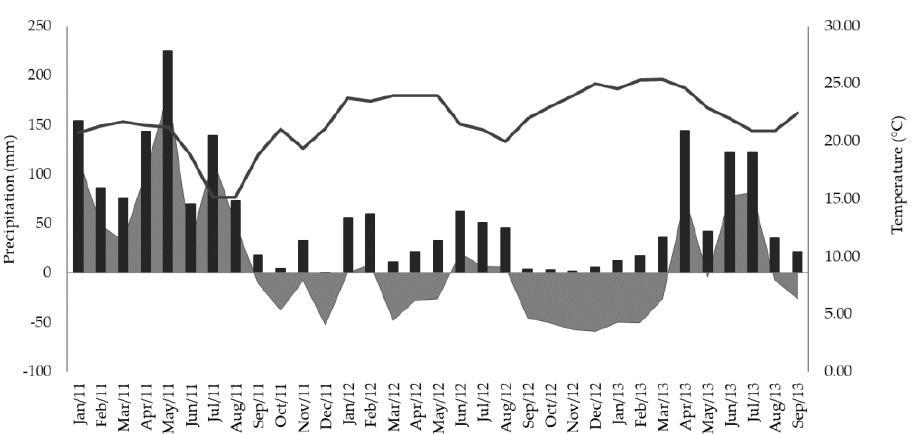
Figure 1. Hydric balance during the experimental period in areas cultivated with forage cactus in Caruaru, PE. Source: Instituto Agronômico de Pernambuco-IPA (2013).